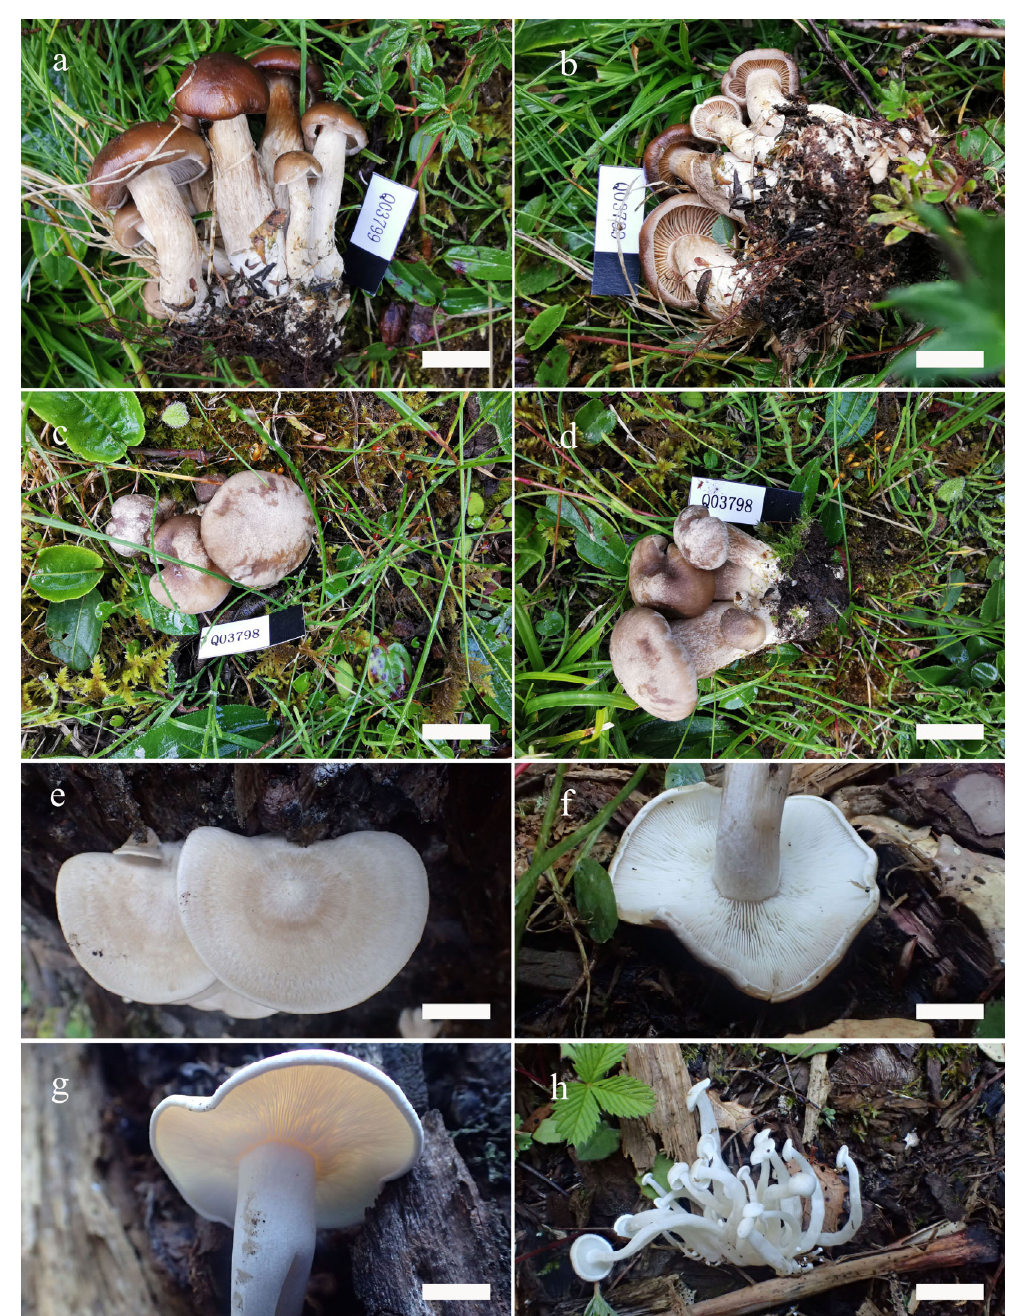
orange-white (6A2), with reddish-gray (7B2) to grayish-red (8C3) when mature, discoloring slightly when touched or damaged, fleshy and solid inside. Taste mild. Odor indistinctive.